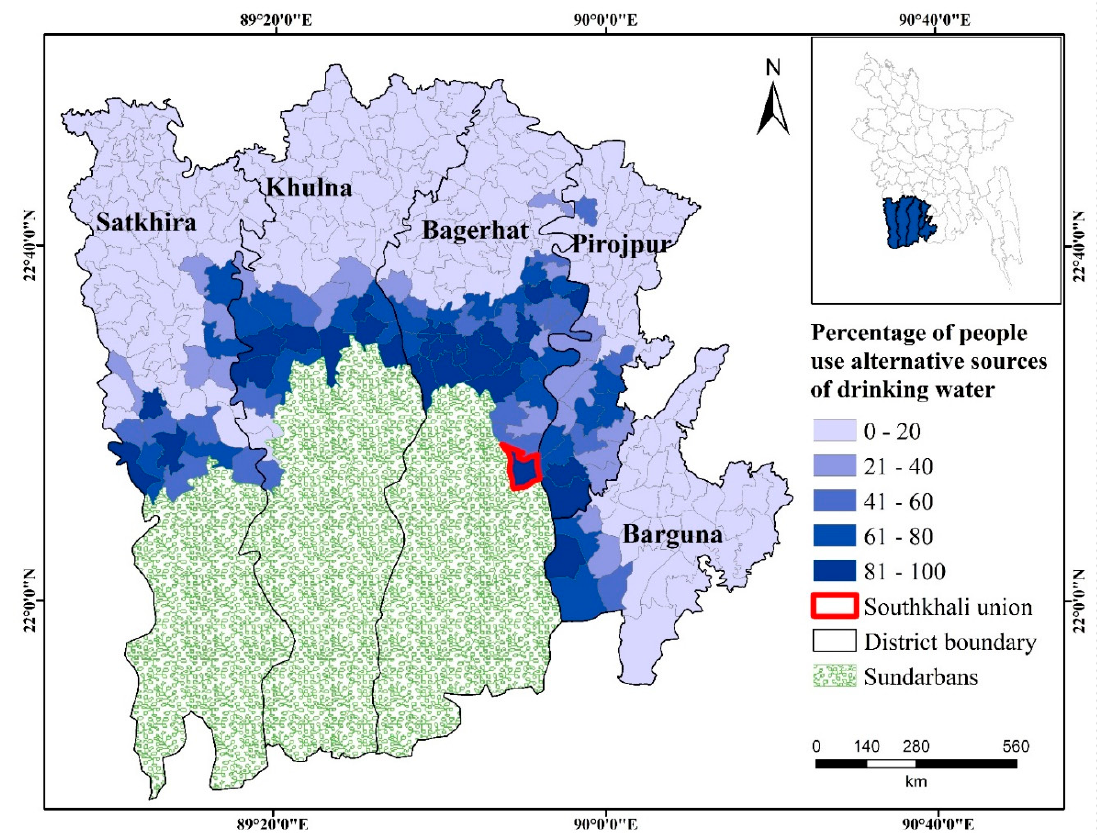
Figure 1. Percentage of population using alternative sources in coastal unions of Bangladesh and Southkhali Union (study area) (source of data: [10]).